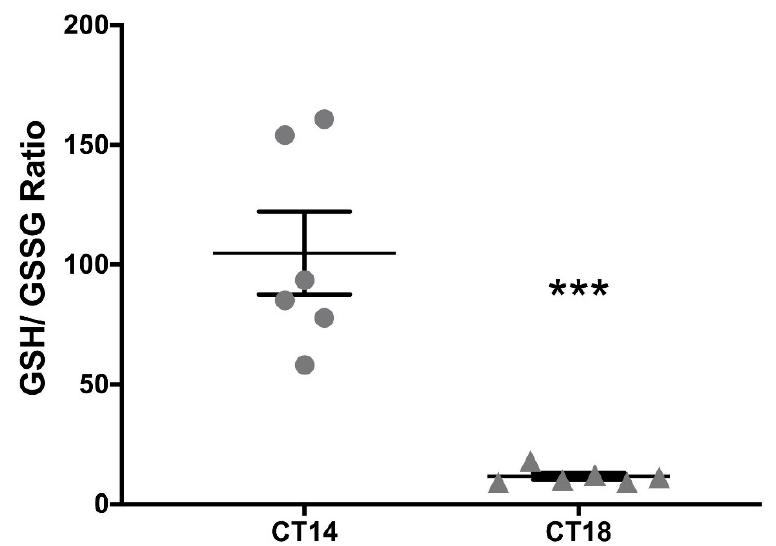
Figure 3. Glutathione couple measurement in the SCN at subjective night. The redox state was assessed as the GSH/GSSG ratio. Brains were collected at CT14 and CT18 and samples were frozen at − 80 °C. SCNs from 2–3 individuals were pooled for measuring reduced (GSH) and total glutathione, inferring oxidized glutathione (GSSG) values using the equation GSSG = (total glutathione—GSH)/2. The rate relation was also calculated as GSH/GSSG, thus indicating a more oxidized environment when the relation was lower. Significantly lower values for CT18 were found, indicating a more oxidized environment at late subjective night (CT14: 104.9 μ m/(mg/mL) ± 42.38 μ m/(mg/mL) vs. CT18: 11.62 μ m/(mg/mL) ± 3.37 μ m/(mg/mL)) (*** p < 0.001 paired t- test; t = 5.38; df = 10; n = 6).